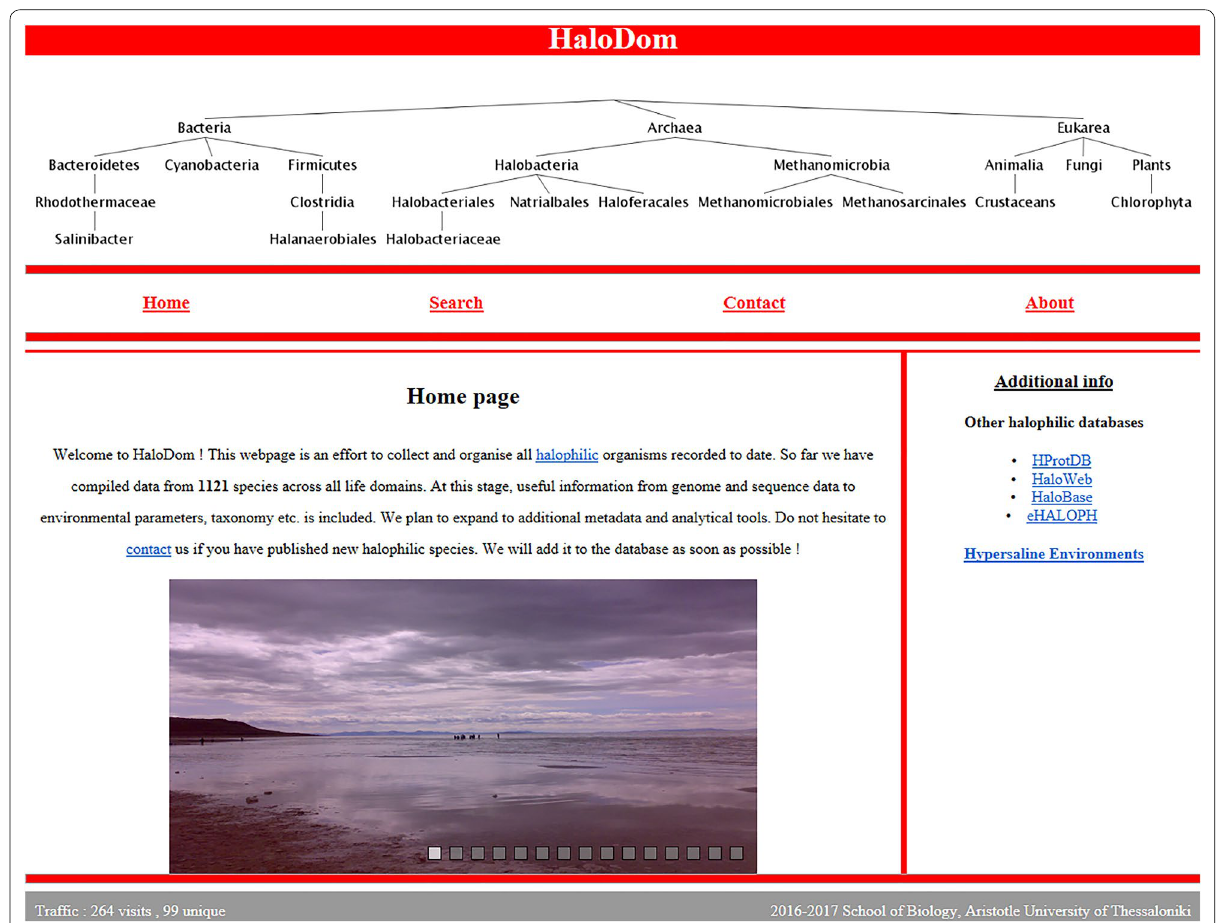
Fig. 2 Homepage of HaloDom contains a welcoming text, a small tree graph and a photo